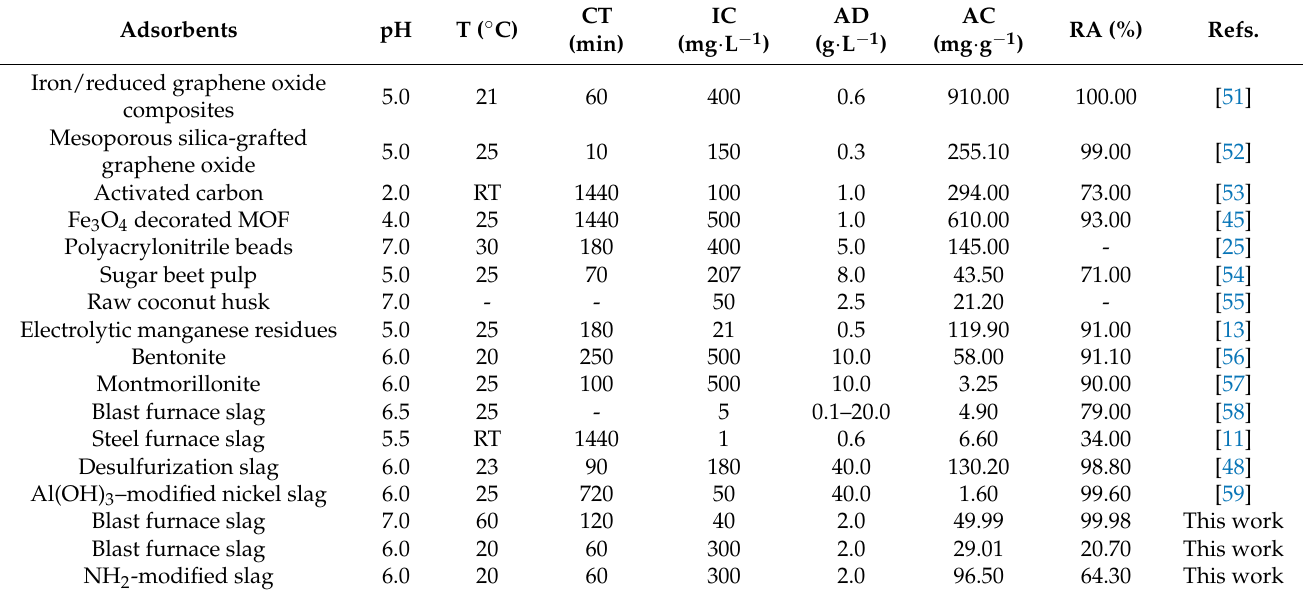
Table 11. Comparison of the lead ion removal performance of various adsorbents.